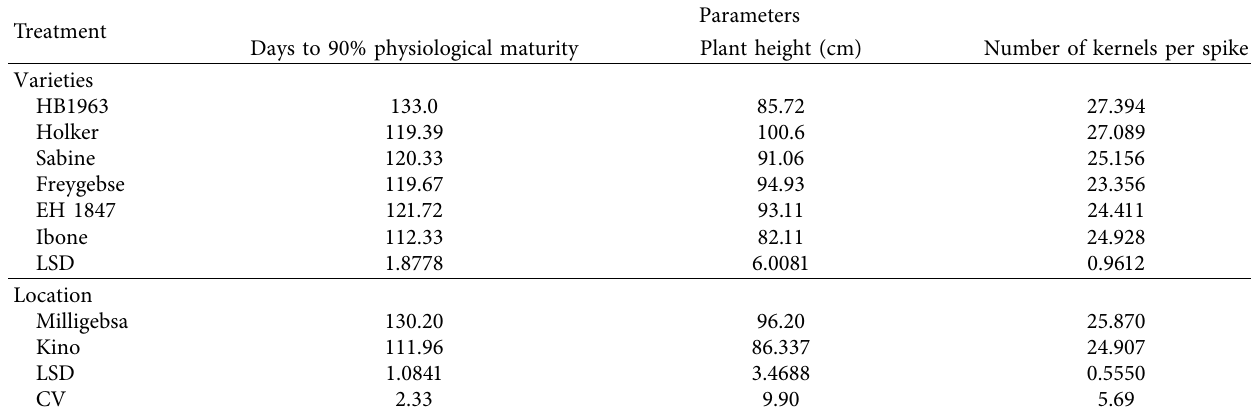
Table 3: Main effect of varieties and location on days to maturity, plant height, and number of kernels per spike of malt barley at Debark, north Gondar, Ethiopia, in 2019.